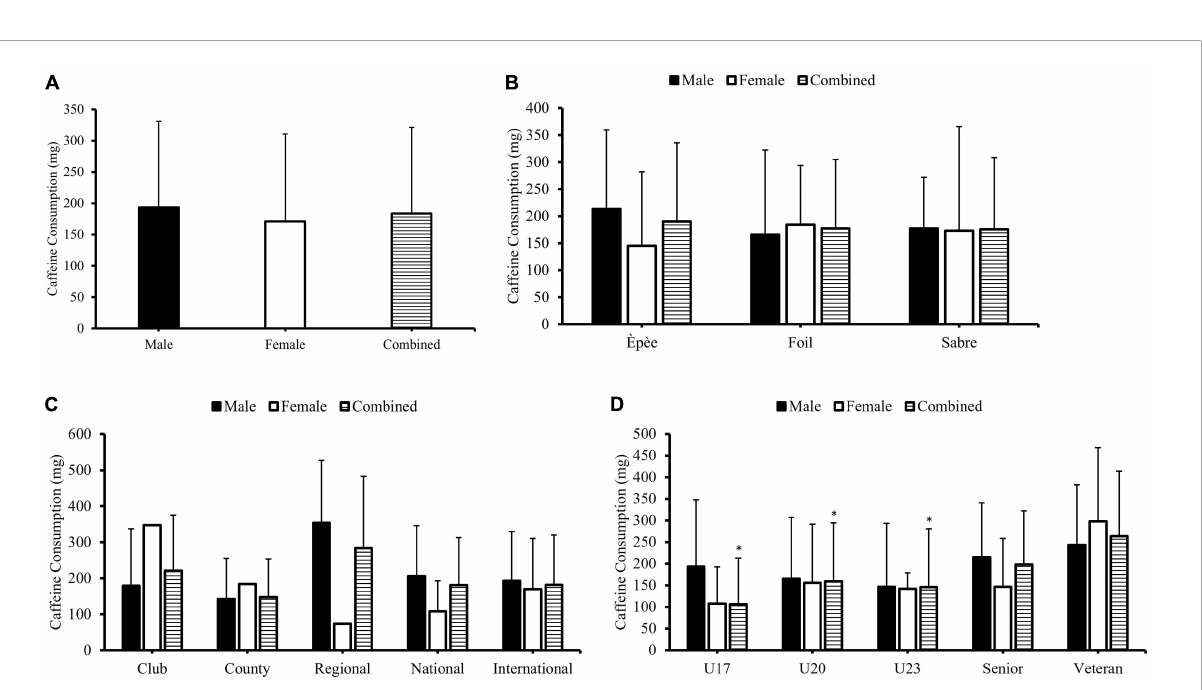
FIGURE2 The differences in the typical caffeine consumption of British Fencing athletes, during the 24-h period outside of fencing training/competition (general caffeine consumption) when comparing sex (A) , fencing discipline participated in panel (B) , competition level (C) , and age group (D) , within British Fencing athletes. ∗ A statistically significant difference ( p < 0.05) in the combined general caffeine consumption in relation to the veteran age group.